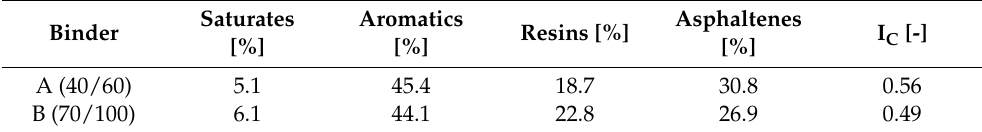
Table 1. SARA fractions and Gaestel index of asphalt